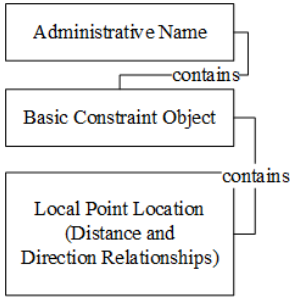
Figure 5. Relationships between address elements.